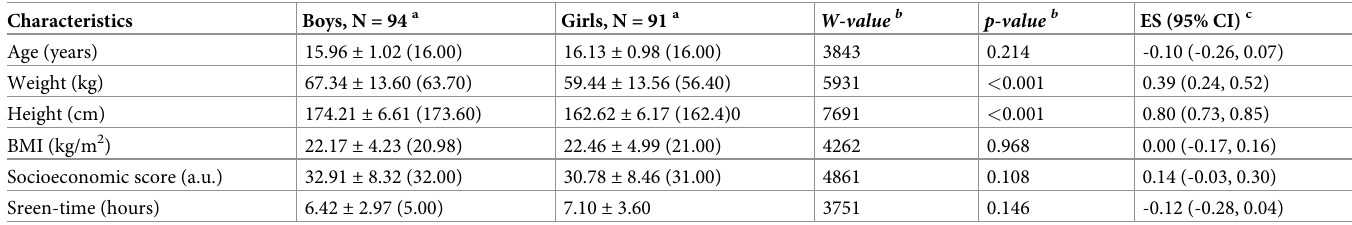
Table 1. Participant